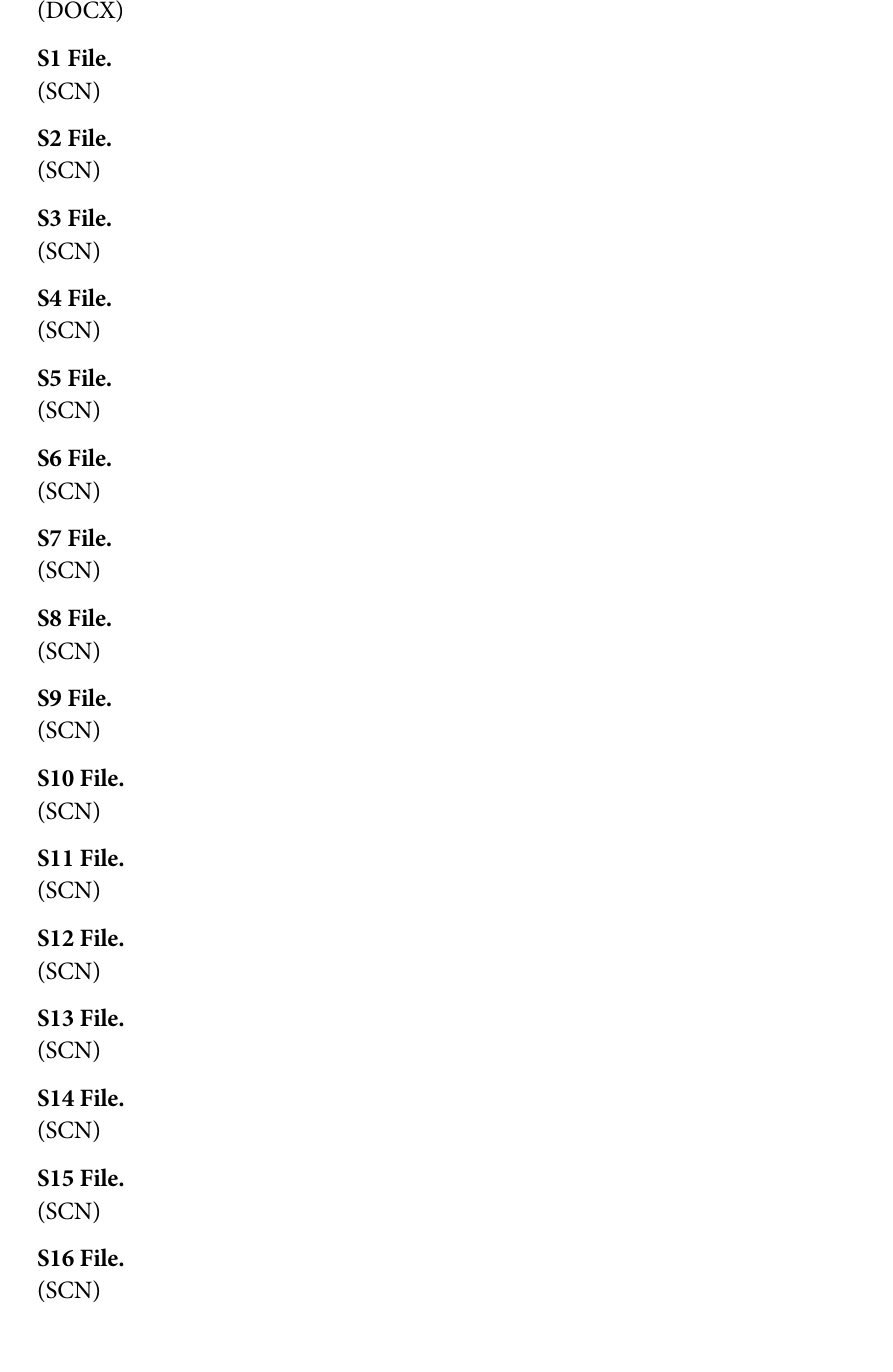
S2 Fig. Effect of EPA on non-mitochondrial function. (A) the effect of EPA treatment on non- mitochondrial respiration. OCR traces are expressed as pmol O2 per min in C2C12 cells and normalized to protein concentration (B). The Relative differences in non- mitochondrial respiration of control and EPA treated group. Significant differences among groups were mea- (TIF) S1 Table. Size of lipid droplets in C2C12 cells induced to brown adipogenesis �